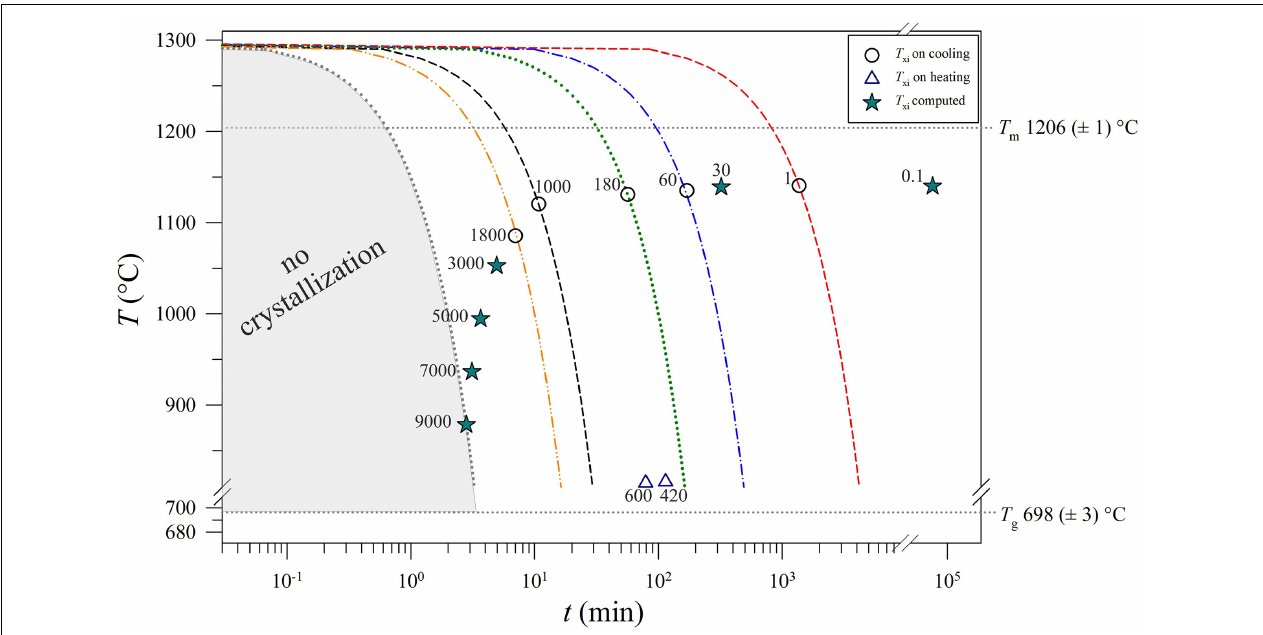
FIGURE 10 | Thermal path and T xi versus t for each run product. The values of T m and T g were computed as the average of T m and T g ( Table 2 ). The T xi trajectory reproduces the uppermost portion of a TTT curve. Circles: measured data. Stars: calculated data by the equations reported in Figure 9 . Triangles: the temperatures computed using the heating rates from this study and Iezzi et al. (2017). All numbers into the plot are expressed in ◦ C/h.